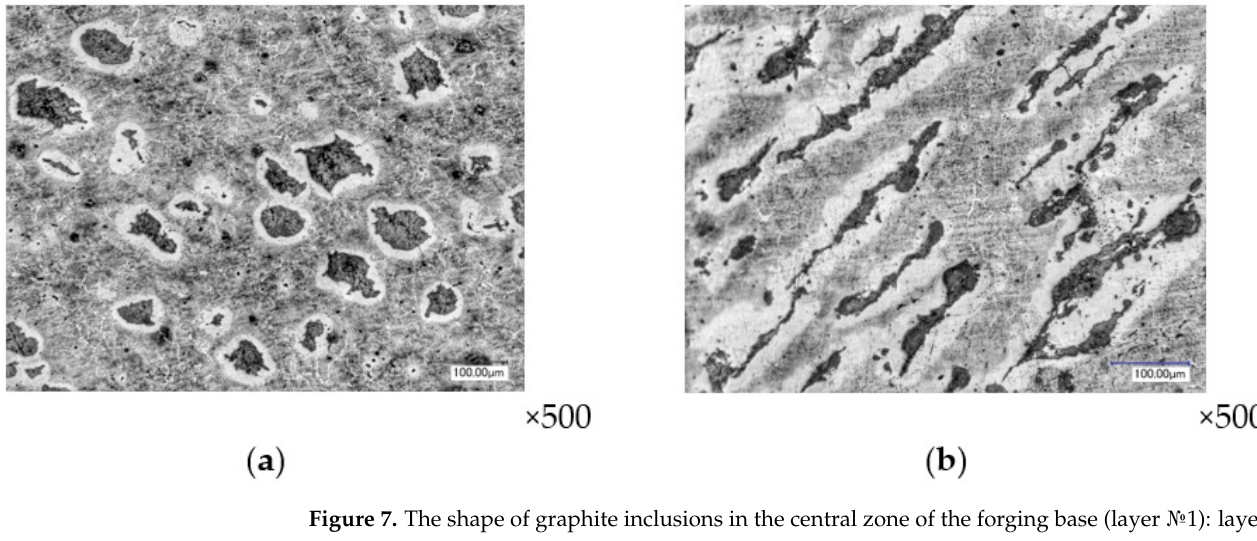
Figure 7. The shape of graphite inclusions in the central zone of the forging base (layer № 1): layered section ( a ) and end section ( b ).